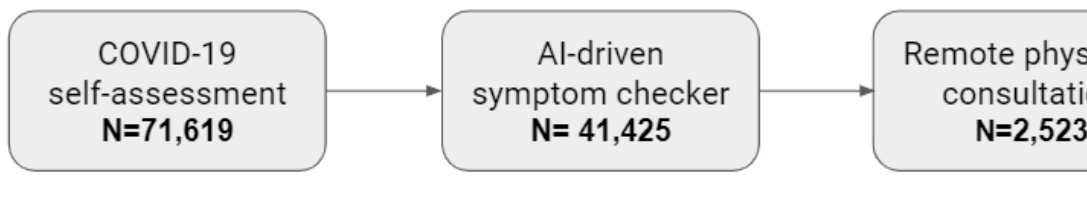
Figure 1. Flowchart describing the cohort of US individuals who used the COVID-19 self-assessment between April 8 and June 20, 2020. AI: artificial intelligence.